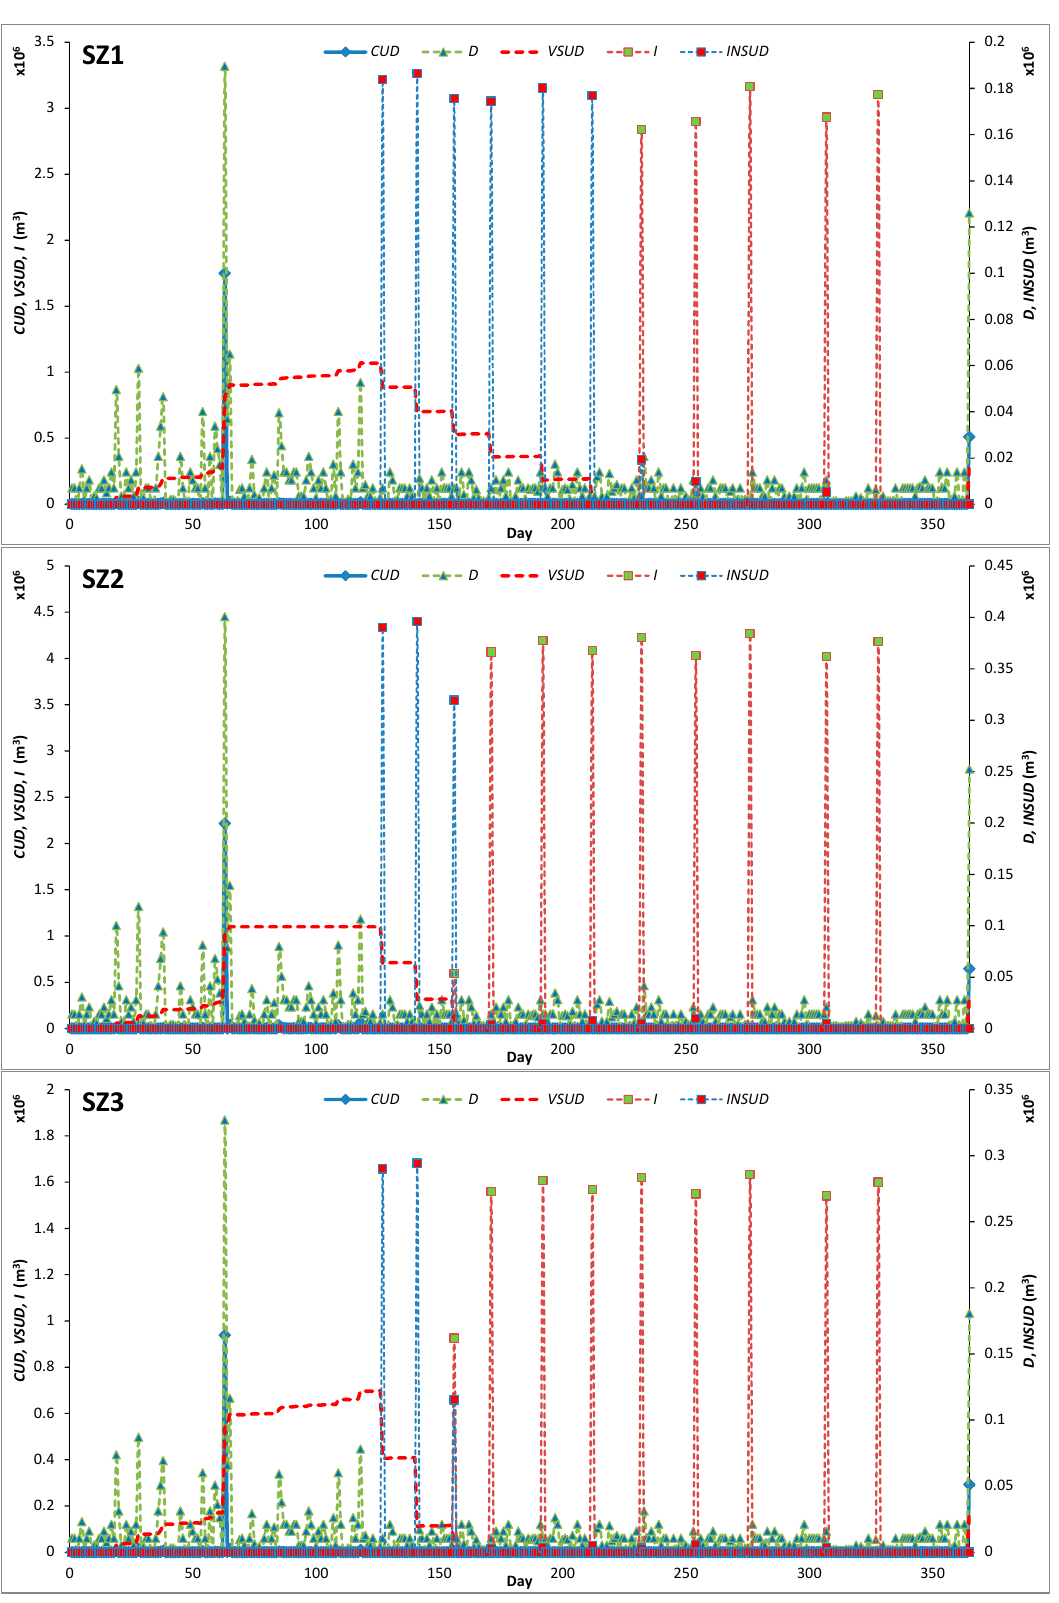
Figure 5. CUD , D , VSUD , I , and INSUD (irrigation from water stored at SUDs) evolution during the year for the three analyzed catchments (SZ1, SZ2, SZ3).